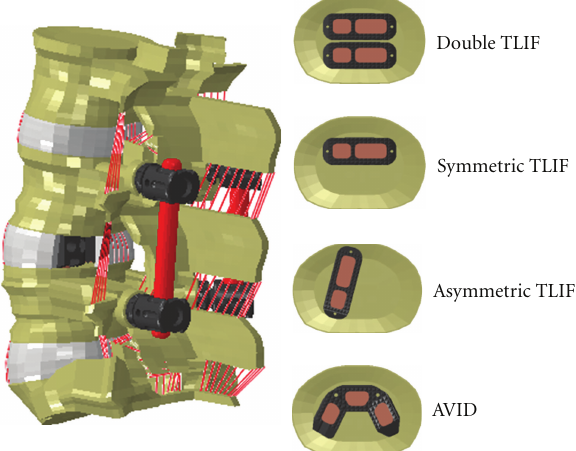
Figure 6: Four configurations of the interbody devices implanted at L4-L5 level in the FE model. (a) double cage TLIF; (b) regular TLIF Symmetrically placed; (c) regular TLIF asymmetrically placed; (d) large footprint TLIF (AVID)